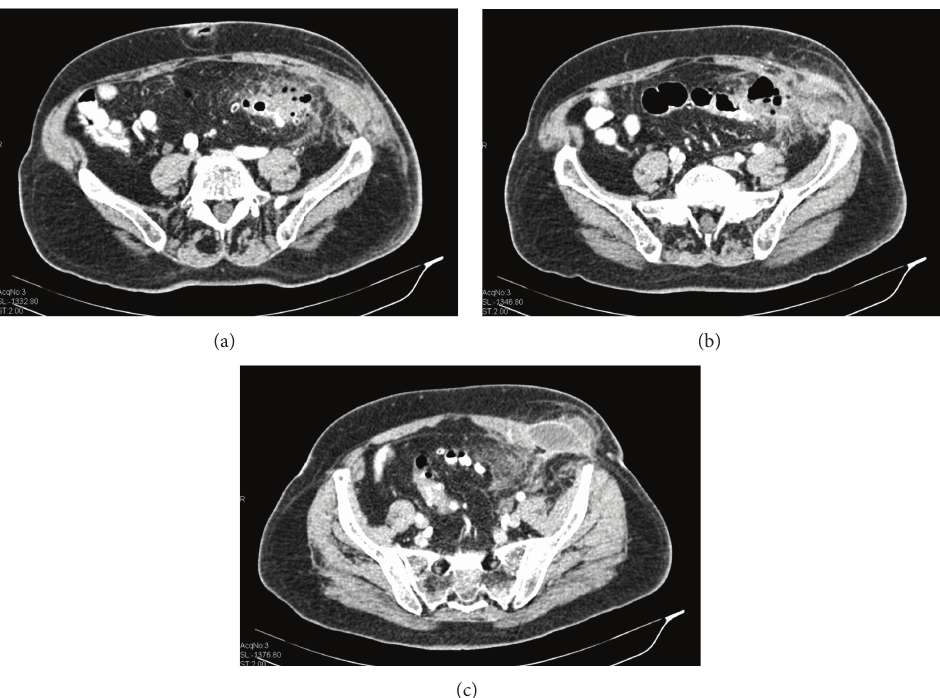
Figure2:Axialimagesofcontrast-enhancedabdominalMDCTshowedwallthickeningwithnarrowingofthelumenandmultiplediverticula of the sigmoid colon. There is also pericolic fat stranding, an umbilical hernia (a), thickening of the abdominal wall ((a), (b)), and extraluminal air collection (b). In image (c), we see a bilocular abscess in the lower left abdominal wall and the communication between the abscess and the intra-abdominal inflammation.